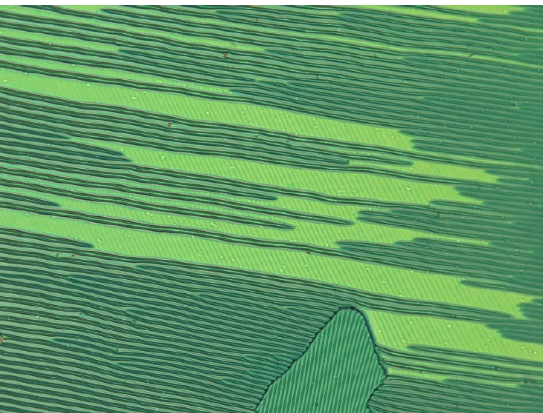
Figure 13. Material used: MGTP7. The twisted cell at a temperature 0.5 °C below the N–N TB transition temperature with a square waveform of amplitude 2 V applied. Some of the stripes start disappearing following application of electric field across a planar-aligned twisted cell. Striped patterns of three different directions can be observed in the same cell.